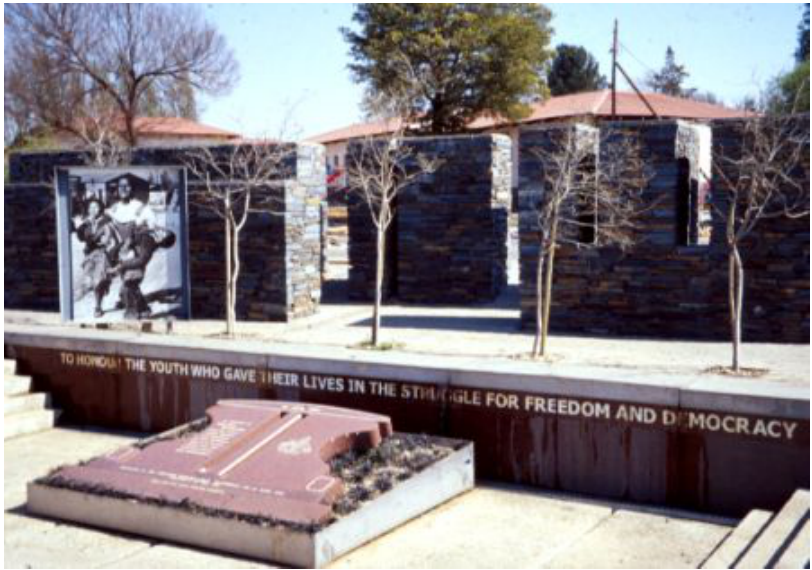
Figure 8. Memorial with photograph by Sam Nzima at the Hector Pieterson Memorial and Museum, Soweto (author’s photograph).